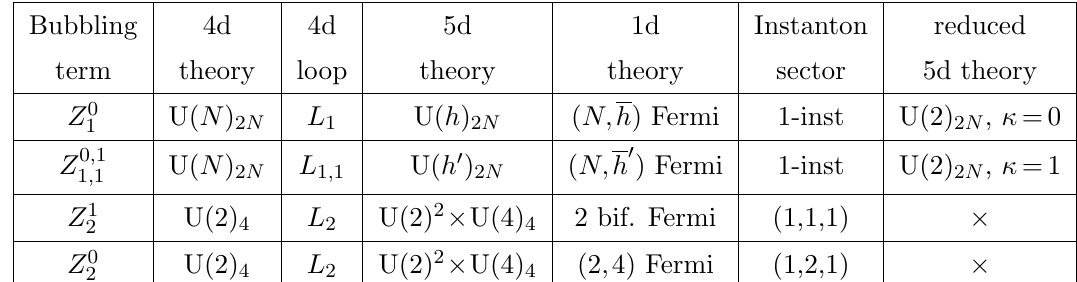
Table 2 . Map between bubbling terms and 5d-4d-1d systems. U( n ) n group with n f (cid:13)avor